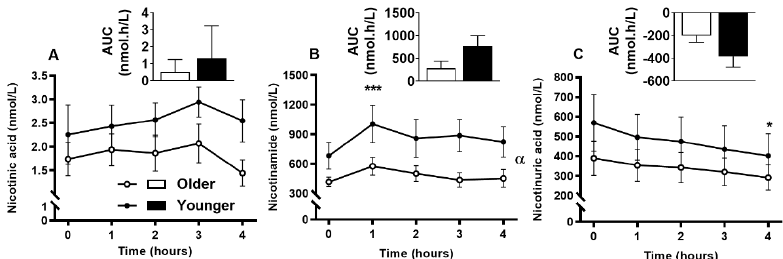
Figure 7. Plasma response of B 3 vitamers, ( A ), nicotinic acid ( B ), nicotinamide, and ( C ), nicotinuric acid at baseline (fasting, time, 0), hourly until four hours (time, 1, 2, 3, 4) and the four hour incremental area under the curve (AUC, represented by bar-graphs) following a single multivitamin and mineral supplement ingestion in older and younger adults. Data for multiple time points was compared using general linear mixed model with time as repeated and age as fixed factors. AUC data was compared with general linear univariate analysis of variance with age as fixed factor. *, p < 0.05; ***, p < 0.001, significant change following supplement intake relative to baseline in both age groups. No significant di ff erence in postprandial change between the age groups. Nicotinic acid concentration did not increase compared to baseline (time e ff ect, p = 0.370), whereas nicotinamide increased (time e ff ect, p < 0.001) with lower concentration in older than the younger adults (age e ff ect α , p = 0.038) and nicotinuric acid decreased continuously throughout the 4-h postprandial period (time e ff ect, p =